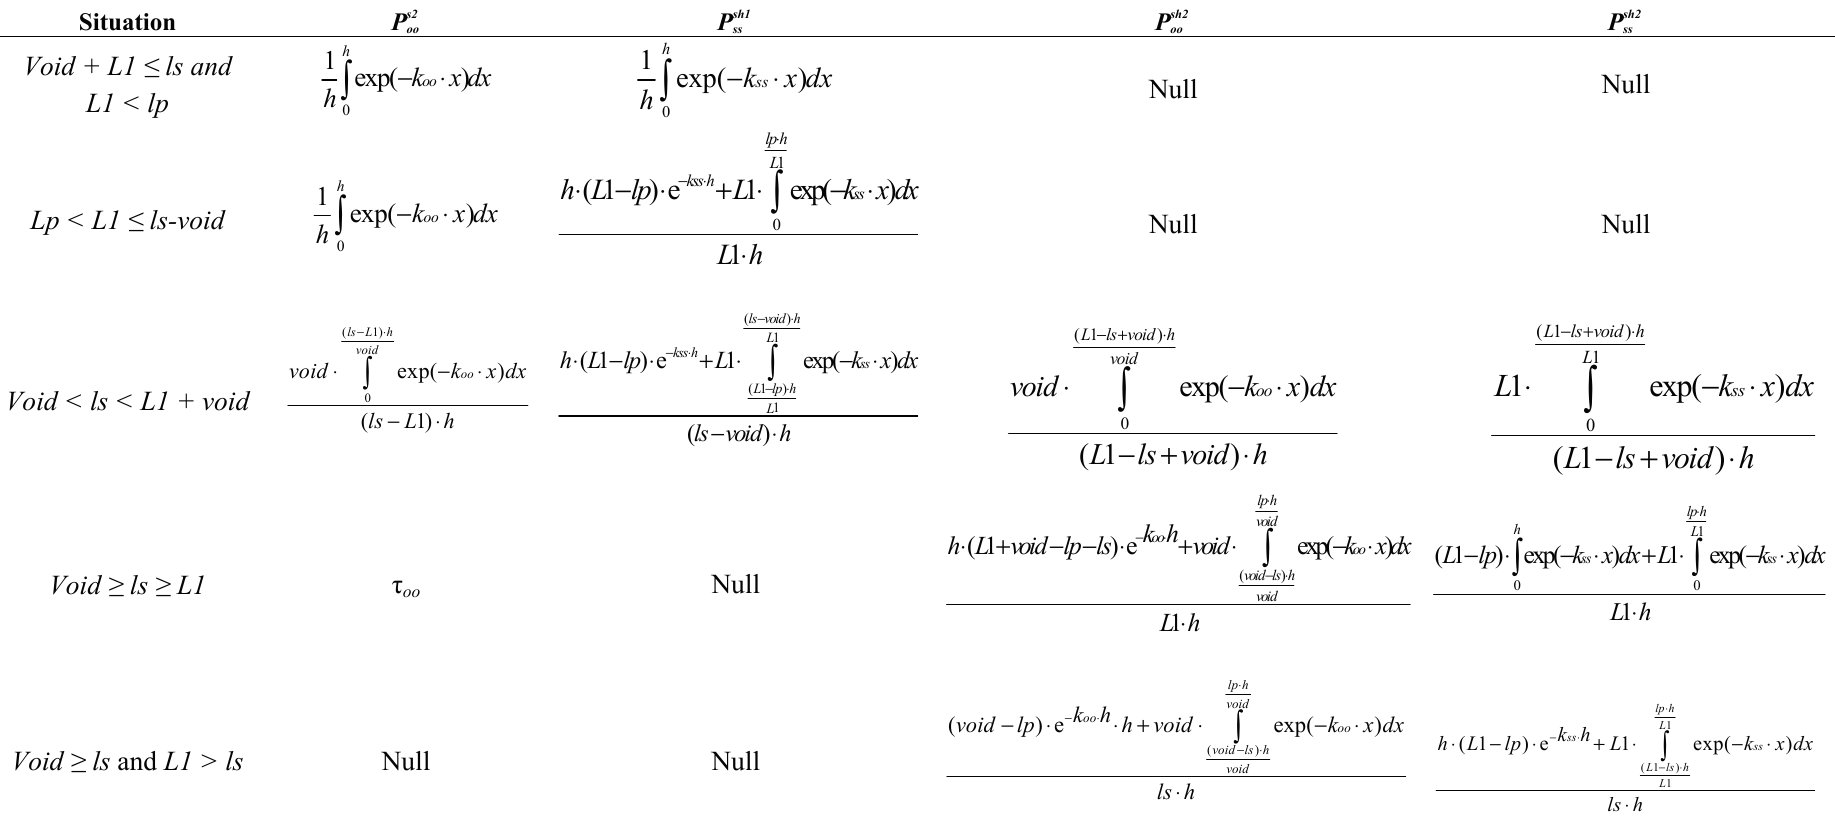
Table 3. The average gap probabilities of the direct light in the solar or viewing directions for different categories background in different forward-scatter